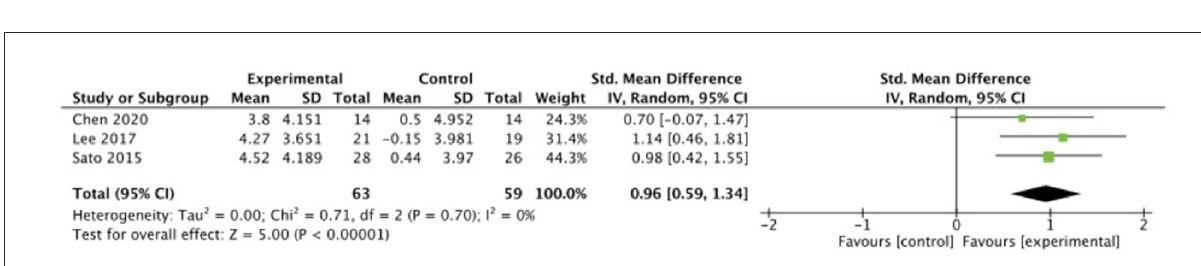
FIGURE6 Random effects meta-analysis forest plot for effectiveness of intervention on measures of FRT balance outcomes.